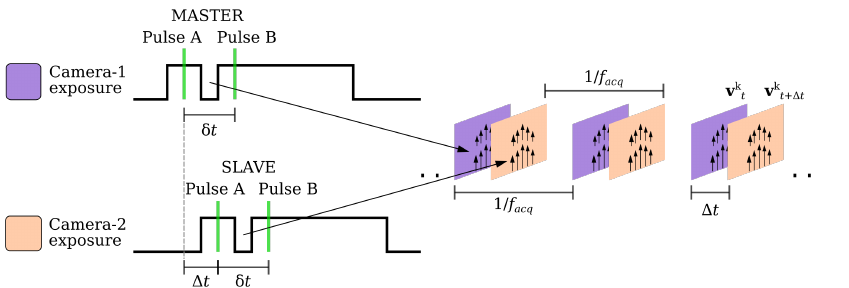
Figure 3. Dual-PIV timing diagram and pairwise time-resolved velocity field